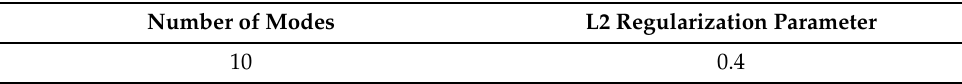
Table 7. Error NN model hyperparameters found through grid search for the heterogeneous model with higher basis dimensions in the first step.